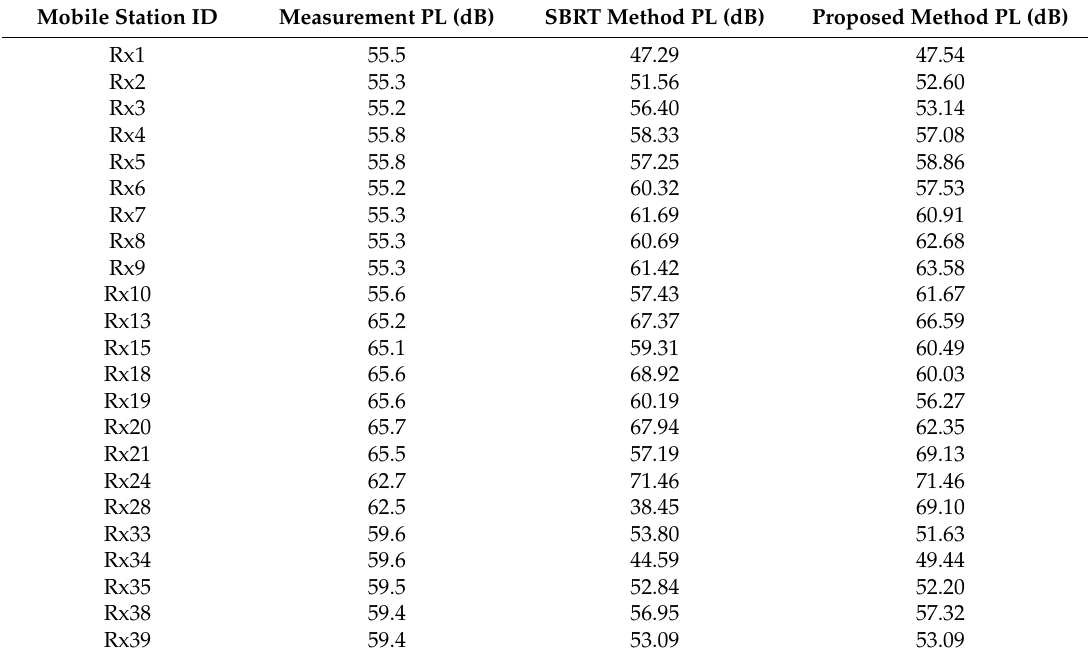
Table 3. Comparison of path loss using measurement, SBRT, and the proposed